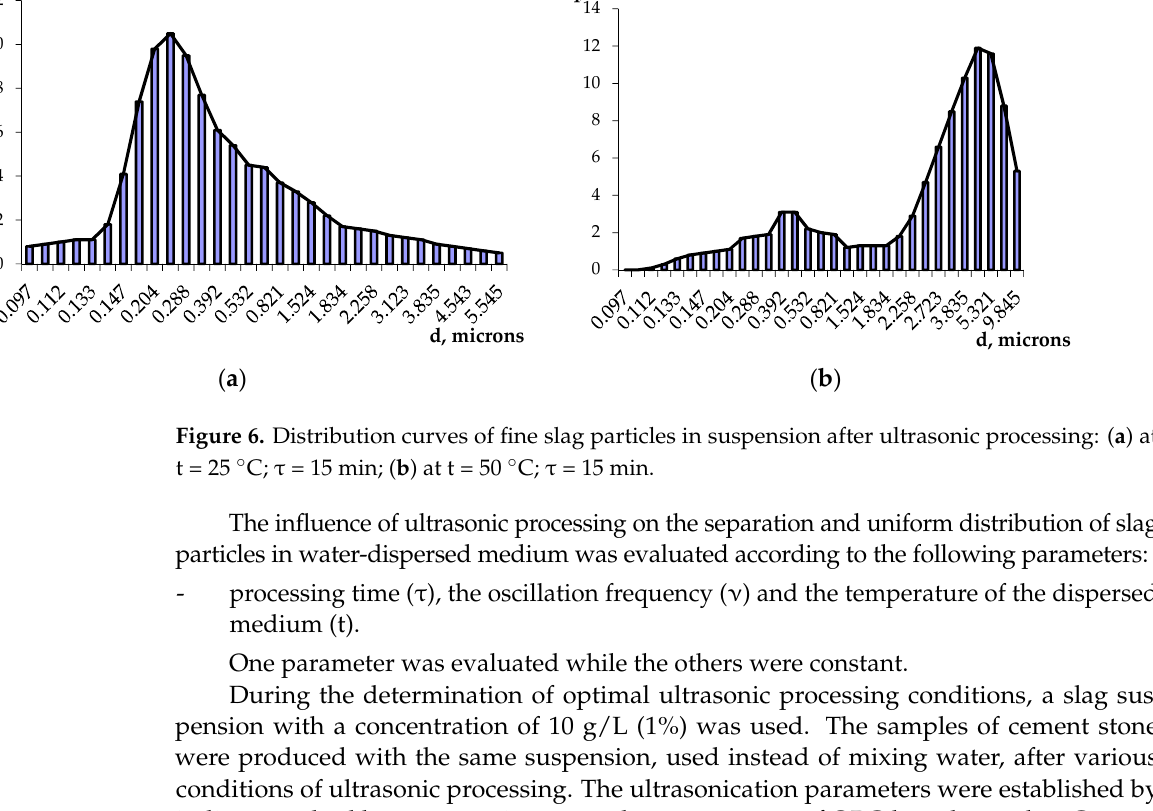
Figure 5. The determination of parameters for the ultrasonic processing of slag suspensions: ( a ) The dependence of the strength of slag-modi fi ed samples on the time of ultrasonic processing; ( b ) The dependence of the strength of slag-modi fi ed samples on the temperature of the dispersed medium.